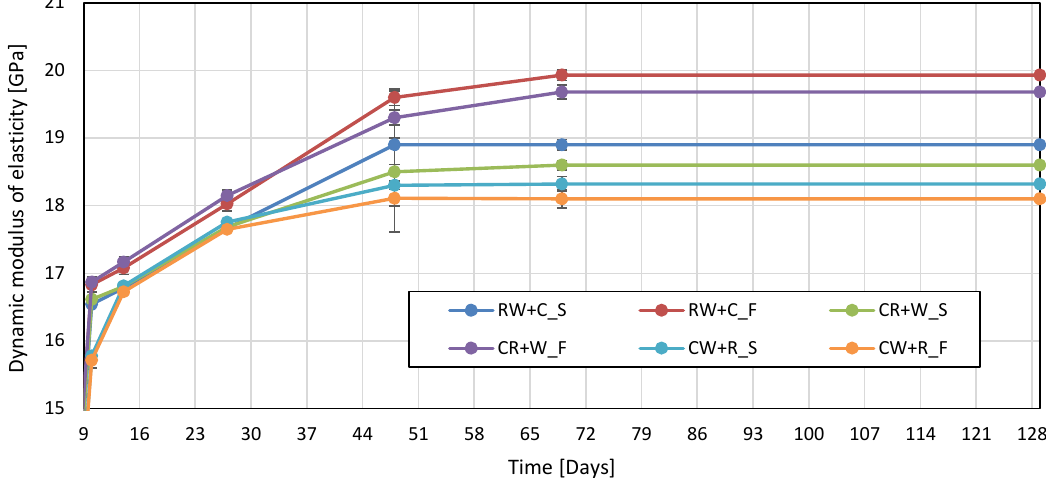
Figure 3. Time dependence of dynamic modulus of elasticity (with standard deviation).